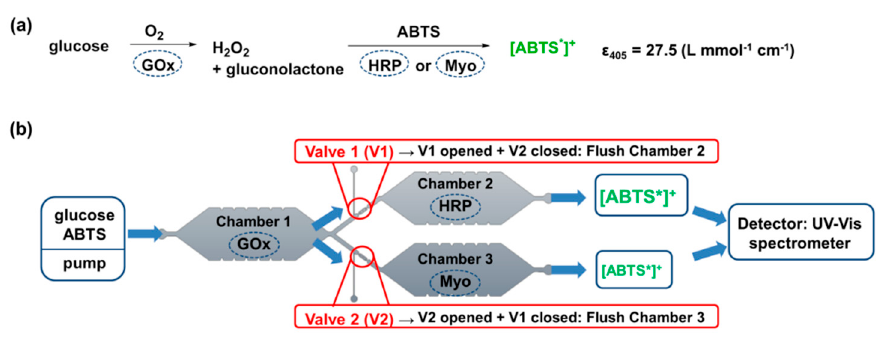
Figure 2. ( a ) Chemical reaction for the two-step enzyme-catalyzed conversion of glucose and ABTS to the UV-Vis active [ABTS*] + . ( b ) Integration of the enzyme-catalyzed reactions in a microfluidic device with three separated reaction compartments and immobilized enzymes. Switching between the bi-enzymatic reactions GOx-HRP and GOx-Myo is done by hydrogel valves and the concentration of the formed [ABTS*] + is measured by UV-Vis spectroscopy.